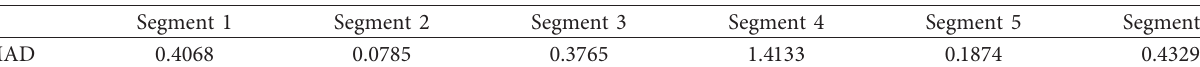
Table 2: MAD of each